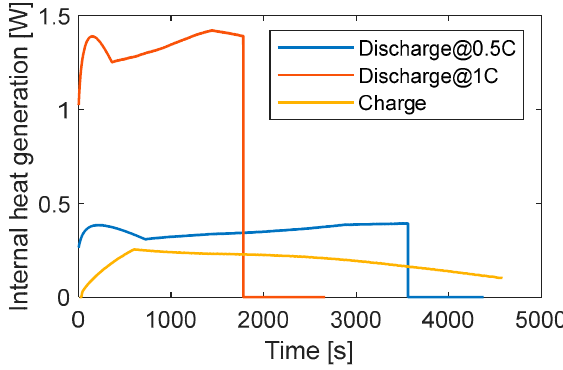
Figure 10. Heat generation in the battery over time for all investigated conditions. Infrared images of the battery are recorded every 10 s and averaged over the surface from the start of the charge/discharge phase to a time that is different according to the test. For the discharge, the current is deactivated when the extracted charge is 50% of the capacity (30 min @ 1 C, 1 h @ 0.5 C) and then the following cooling is recorded for 15 min (Figure 11, top). On the other hand, for the charge, the Constant Current Constant Voltage (CCCV) method is applied. This consists of an initial constant current until the maximum voltage of 4.2 V is reached, and then a constant voltage with decreasing current down to 0 at the end of the charge. The recorded images contain only the charging phase when the current is applied; the cooling process at the time of the current cut-off is not investigated. The presence of an internal source of heat produces an increment in the temperature of the battery during its operation. The graphs at the top of Figure 11 report the curves of temperature and current for the discharge at 0.5 C and 1 C. It can be seen that the typical heating behavior is reproduced; the temperature increase is fast at the beginning and then decreases according to the balance equation reported in Equation (12). At the start, the battery is in thermal equilibrium with the surrounding environment; the term relative to the convective heat transfer is small because of the low temperature variation; on the contrary, the one due to the heat accumulation is greater.